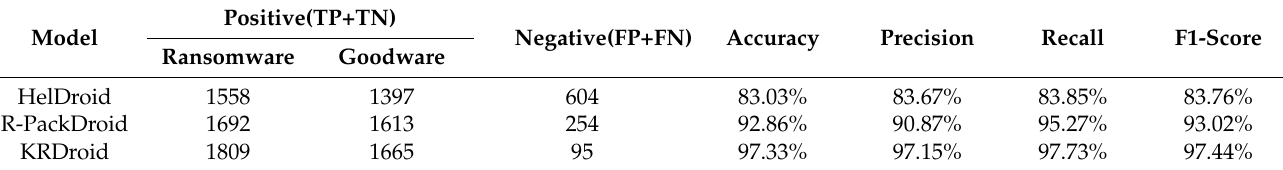
Table 6. The comparison results of KRDroid, R-PackDroid, and